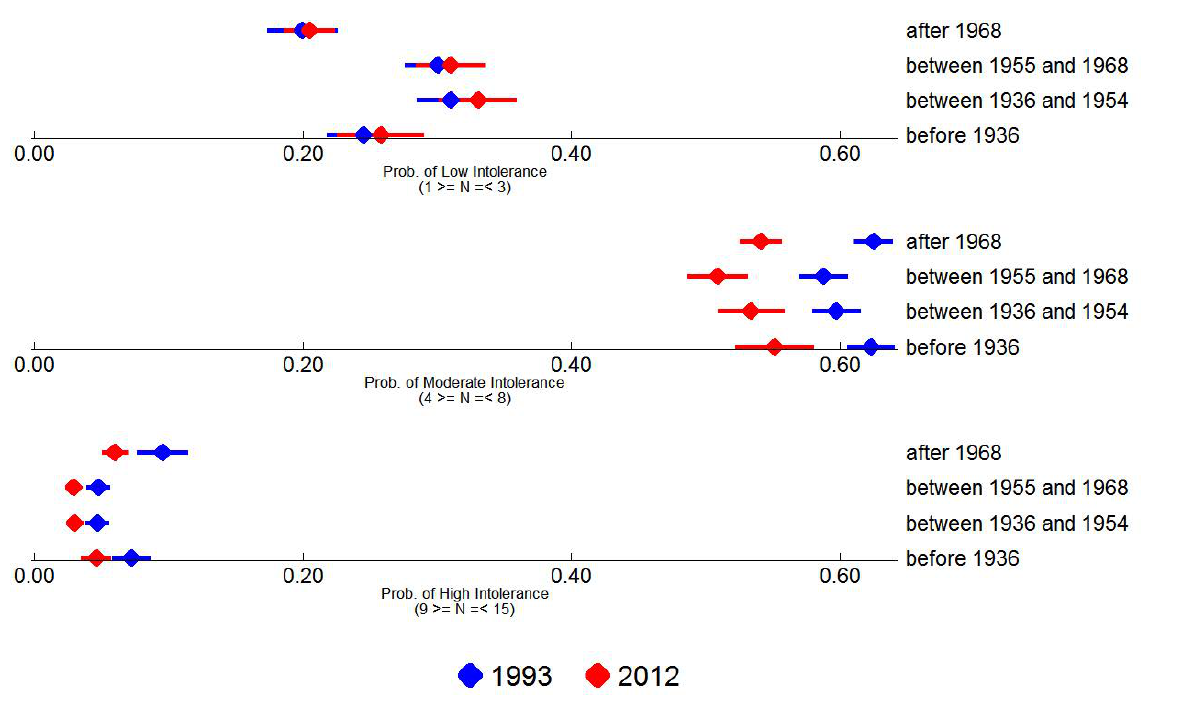
Figure 4: Predicted probability of falling at different levels of symbolic exclusion intensity from count compo- nent of the preferred zero-inflated Poisson specification by cohort